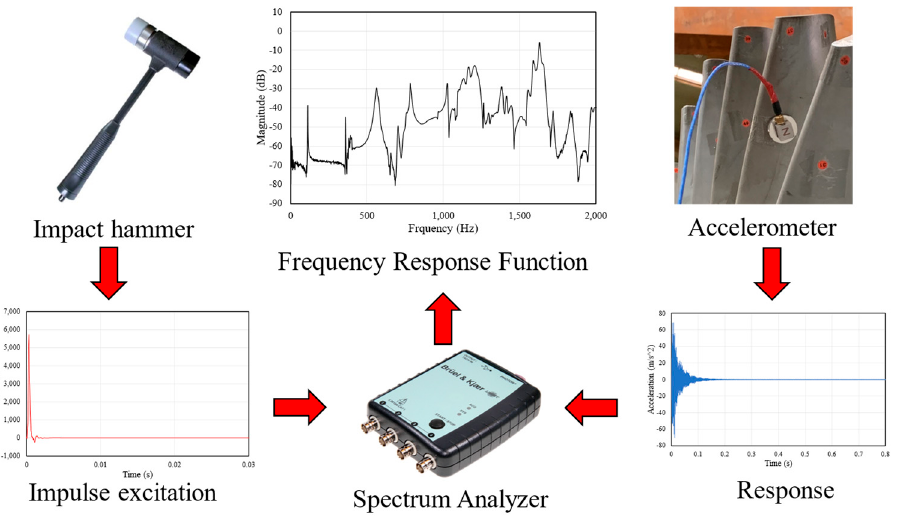
Figure 1. A flowchart of experimental signal